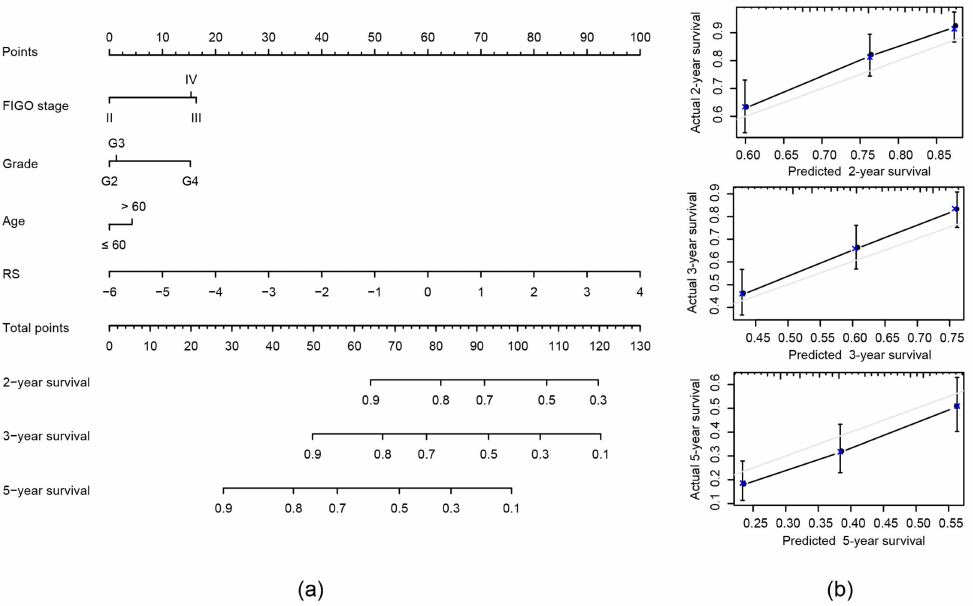
Figure 7. Construction of nomogram model: ( a ) Nomogram predicting 2-, 3- and 5-year OS for patients with EOC. The nomogram is applied by adding up the points identified on the points scale for each variable to a total points amount. Finally, beneath the total points, the probability of 2-, 3- or 5-year survival is projected on the bottom scales. ( b ) Calibration curves for nomogram predicted 2-, 3- and 5-year OS for patients with EOC in relation to actual survival.